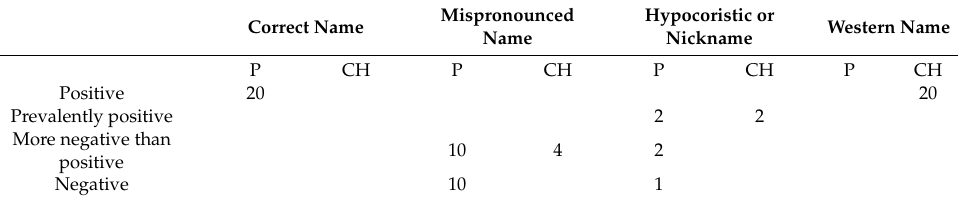
Table 3. Reaction to di ff erent ways of being